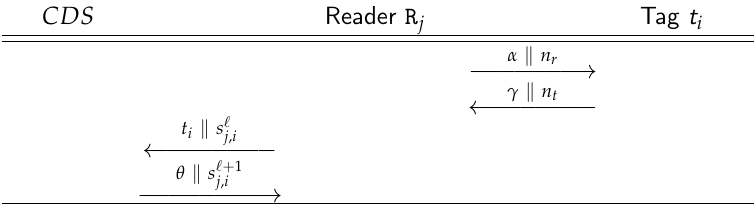
Figure 1. Our Overall